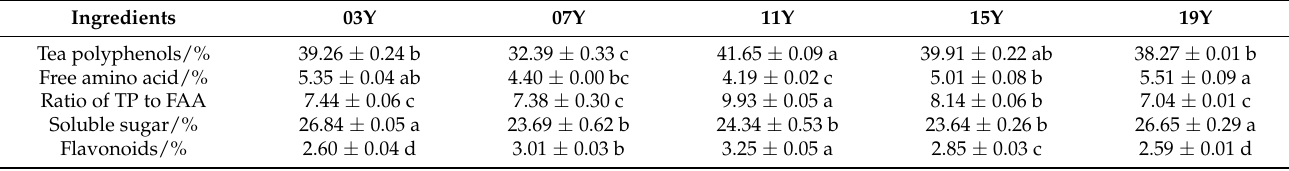
Table 1. Analysis of conventional components from the freeze-dried powder extracted from the aged Chinese green tea (HSGT) a .